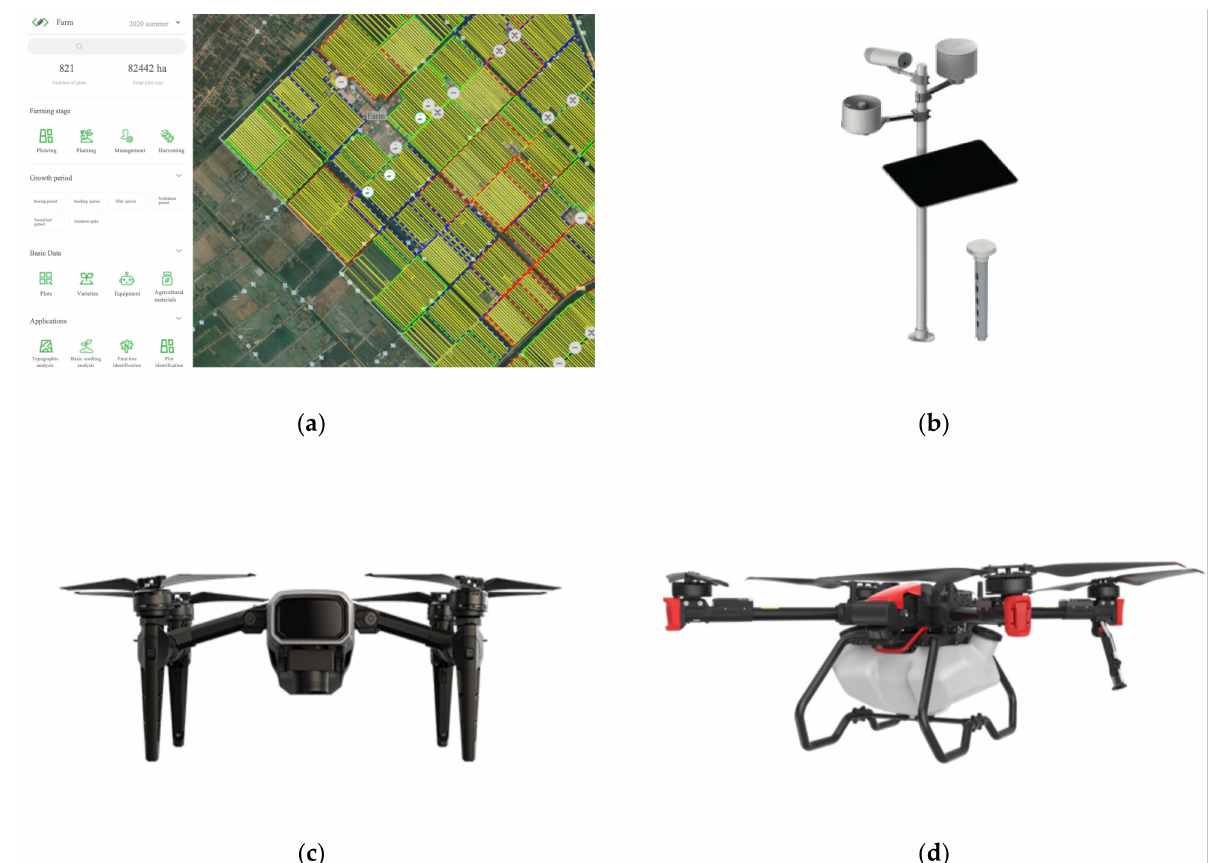
Figure 2. Agricultural equipment: ( a ) Smart agriculture system; ( b ) Agricultural IoT equipment; ( c ) Remote sensing drone; and ( d ) Agricultural